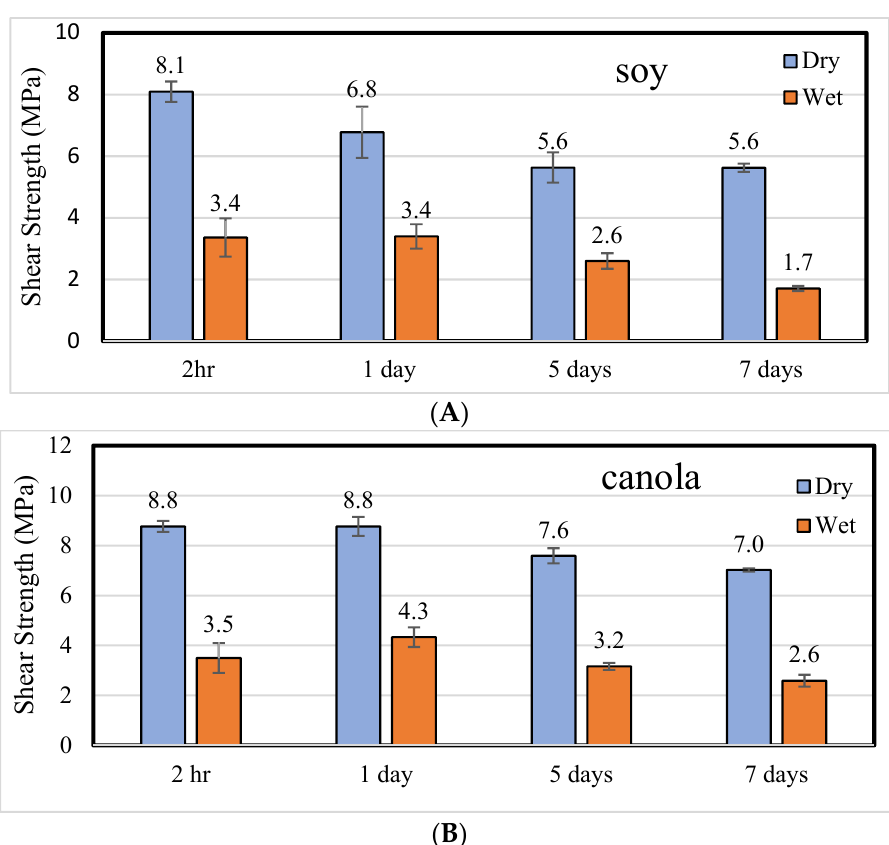
Figure 1. ABES shear strength (MPa), dry and wet, of the soy ( A ) and canola ( B ) adhesives (25% flour solids) with 50% pMDI (50 g pMDI/100 g flour) added to the dry flour and water added later.